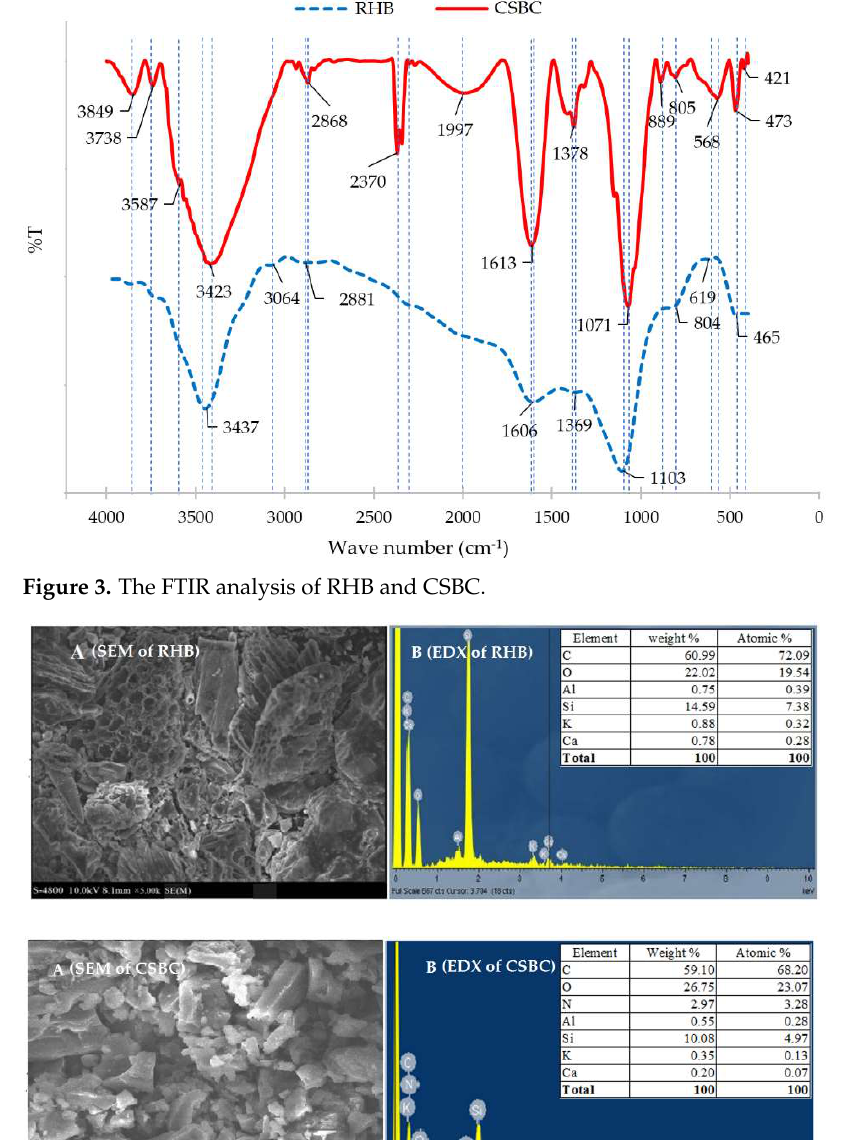
Figure 4. SEM-EDX analysis of RHB and CSBC; ( Figure A upper ): SEM of RHB; ( Figure B upper ): EDX of RHB; ( Figure A lower ): SEM of CSBC; ( Figure B lower ): EDX of